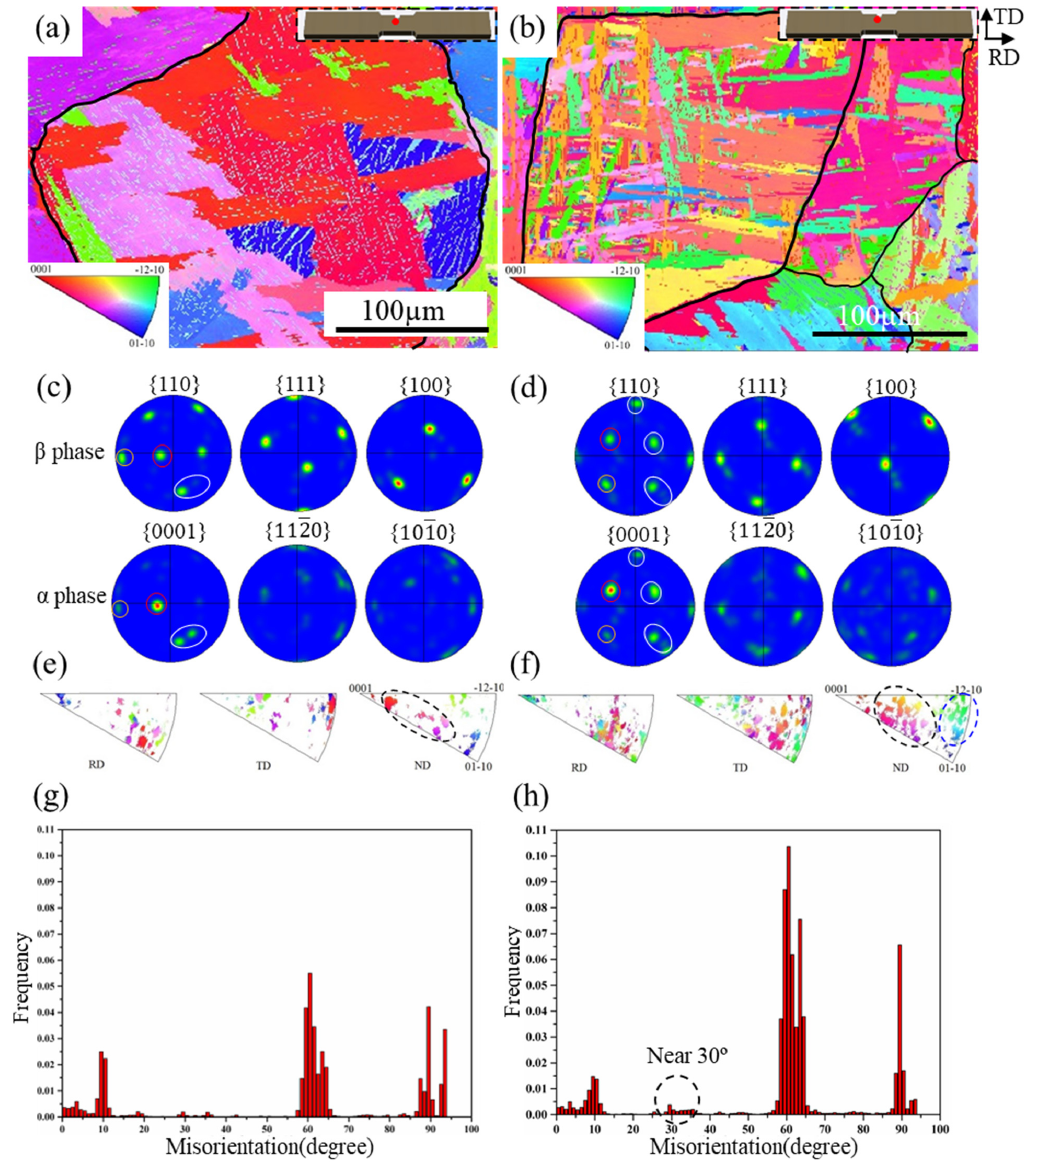
Figure 4. EBSD patterns of ( a ) FC and ( b ) OFC specimens (the insets of upper right show locations on the tensile specimens); pole figures of ( c ) FC and ( d ) OFC specimens; inverse pole figure of α phase in ( e ) FC and ( f ) OFC specimens; and misorientation angle of ( g ) FC and ( h ) OFC